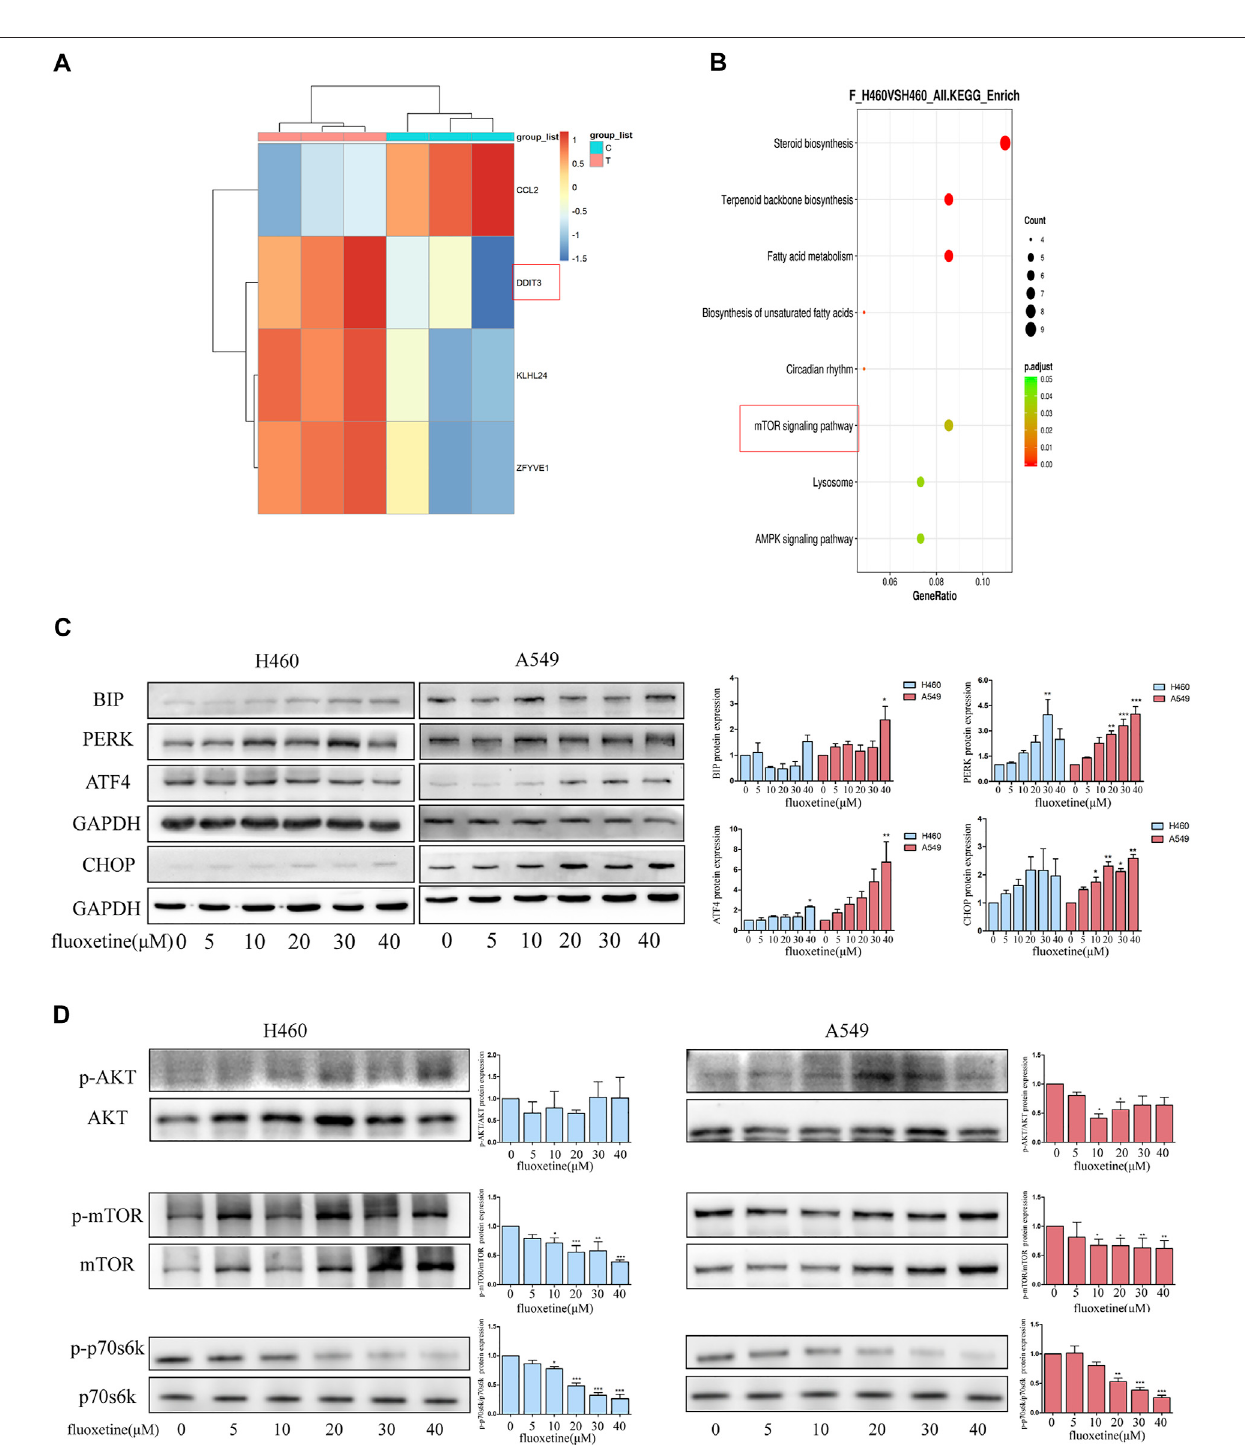
FIGURE 5 | Fluoxetine had a connection with ER stress and mTOR signaling pathway. (A) Autophagy-related genes were analyzed in a gene set. (B) Top 8 enriched KEGG pathways. (C) Western blot was used to analyze the expression ER stress related proteins, including BIP, PERK, ATF4, and CHOP. The images were collectedfromdifferentpartsofthesamegel. (D) Westernblotwasusedtoanalyzetheexpressionofp-AKT,AKT,p-mTOR,mTOR,p-p70s6k,andp70s6k.Theimages were collected from different parts of the same gel. Data are presented as mean ± SD; * p < 0.05, ** p < 0.01, *** p < 0.001.